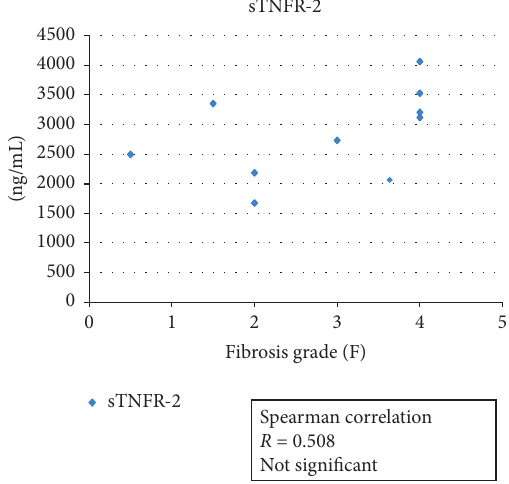
Figure 2: The association between the patients’ serum soluble TNFR-2 level and hepatic fibrosis grade ( n � 10). Spearman’s correlation was obtained. There was no significant association ( R � 0.508).